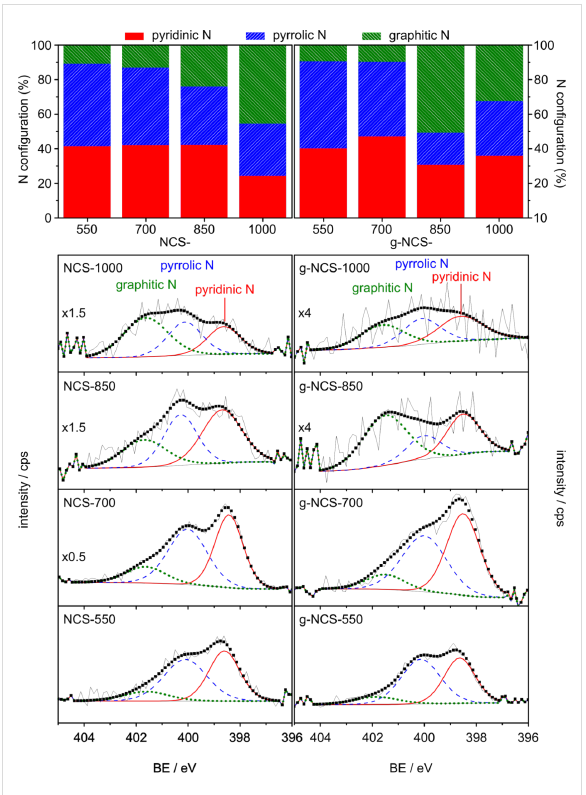
Figure 5: XPS data. Top: N configuration of the NCS and g-NCS cata- lysts; below: XPS spectra of N 1s region for all catalysts with fitted signals indicating contributions from graphitic, pyrrolic and pyridinic N; the XPS spectra of NCS-1000, NCS-850, NCS-700 and NCS-550 are reprinted with permission from [27], copyright 2019